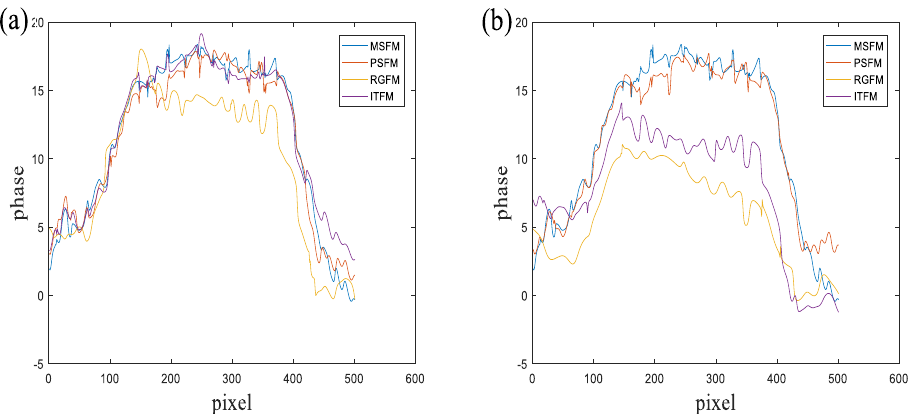
Figure 11. Profiles of different spatial filtering methods under noise: ( a ) speckle noise with a mean of 0 and variance of 0.02; ( b ) Speckle noise with a mean of 0 and variance of 0.04. Table 1. MSE of the reconstructed phases for automatic spatial filtering methods.